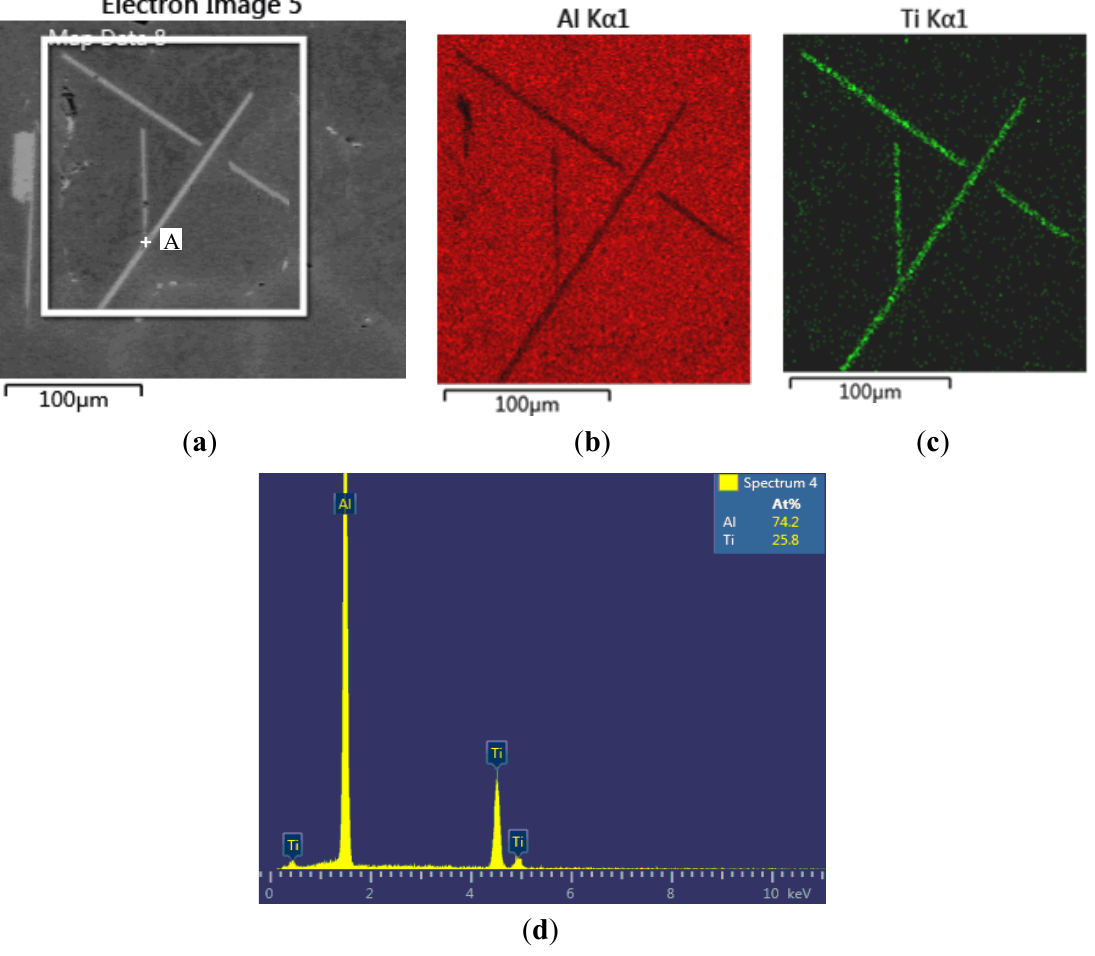
Table 1. Microstructural parameters of TiAl